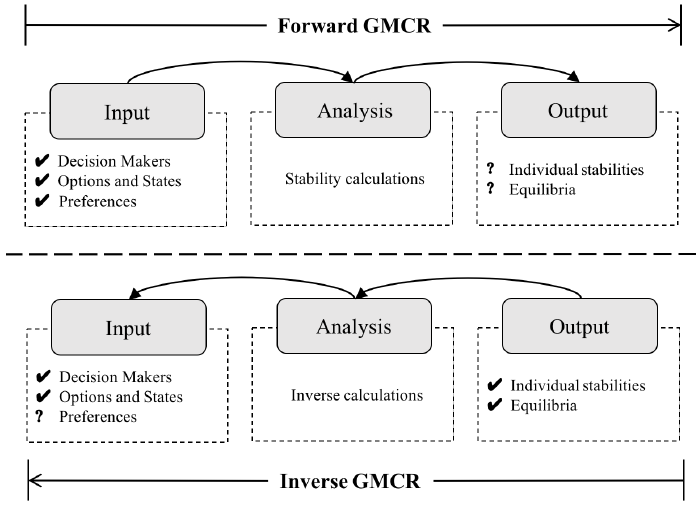
Figure 2. The logic comparison of forward and inverse Graph Model of Conflict Resolution (GMCR) (adapted from